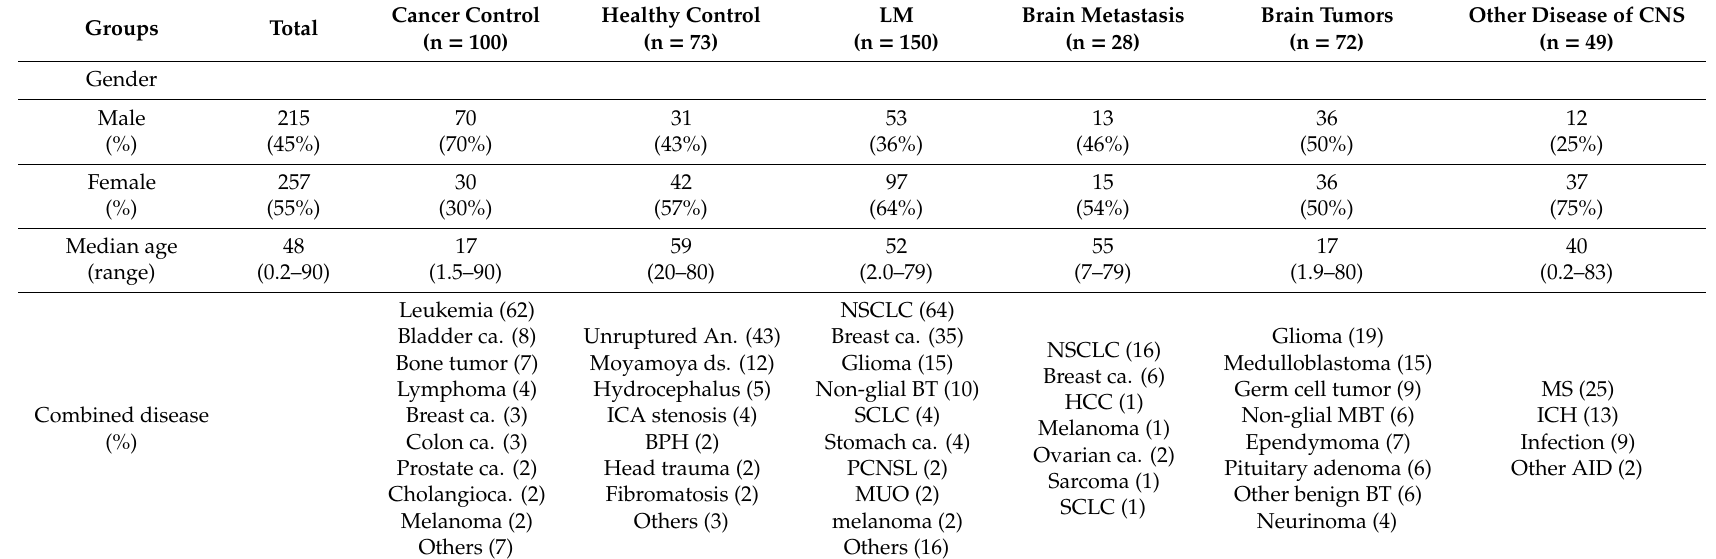
Table 1. Clinical characteristics of cerebrospinal fluid (CSF) sample analysis (n =